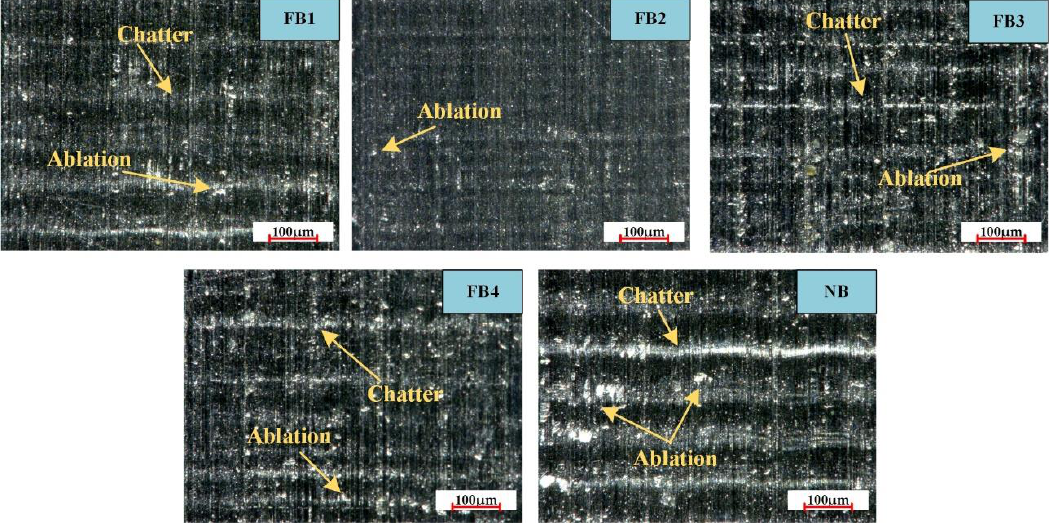
Figure 15. Surface morphology of the workpieces by different broach surfaces at 40 mm/s.